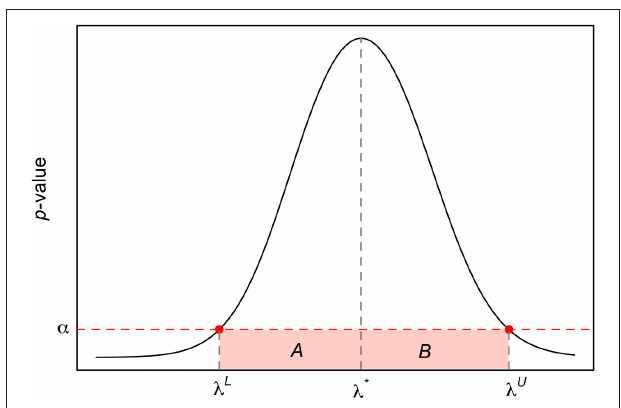
FIGURE 1 | Construction of 100 × (1 − α ) CI for λ * using the inverse probability method. The x -axis corresponds to the plausible values of λ in Equation (4), the y -axis to the p -value of the normality test, and the horizontal dotted line the type I error probability, α . It is worth mentioning that the relationship between λ and the p -value of the normality shown here is for illustration purposes